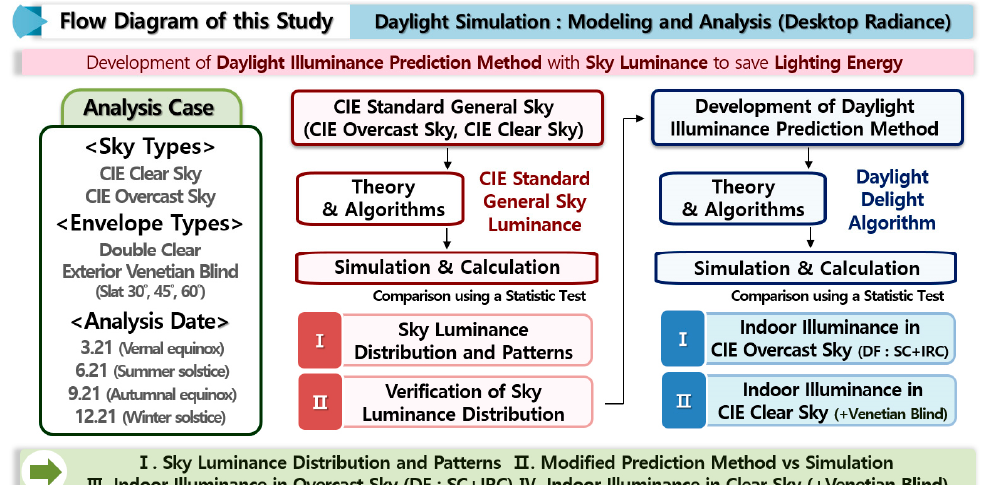
Figure 1. Flow diagram of this study.